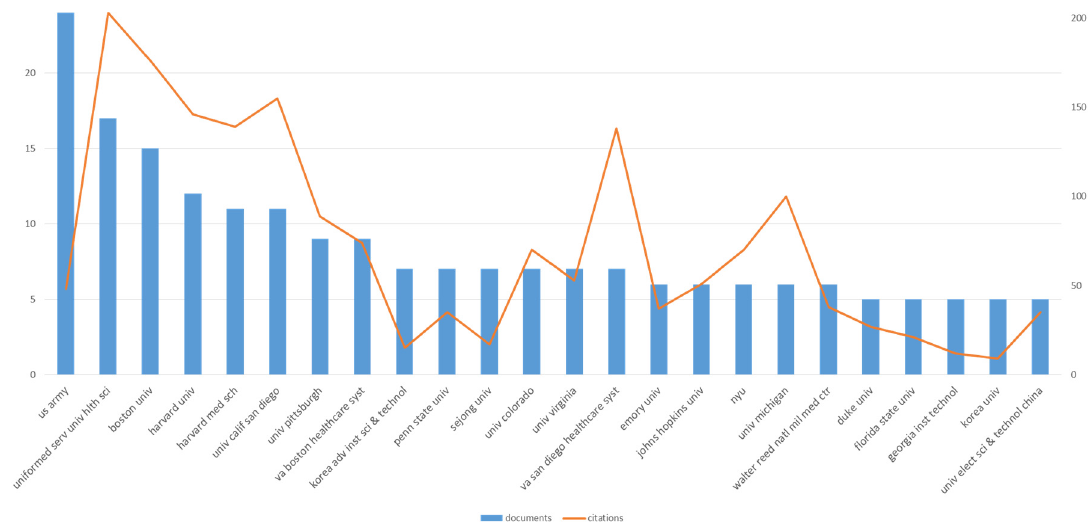
Figure 17. Org analysis; Most important by documents and citations.